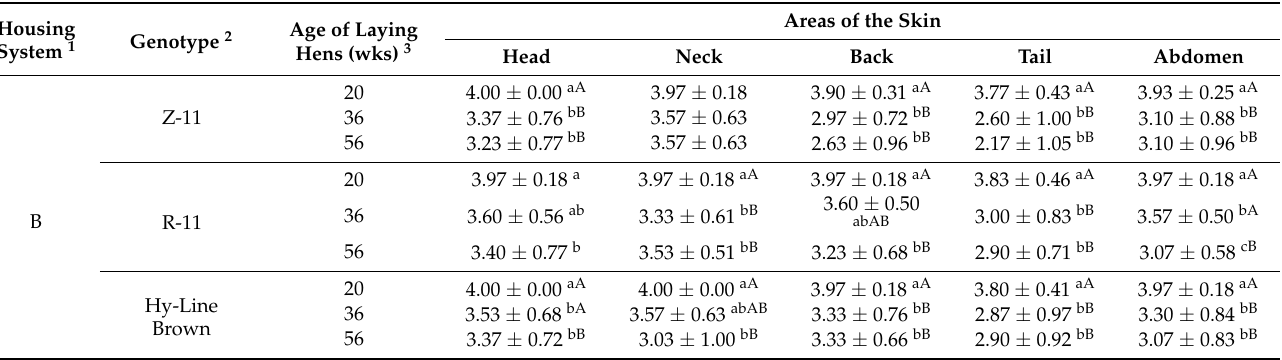
Table 1. The effect of the type of alternative housing system, genotype, and age of hens on the condition of plumage (on a scale of 0–4 points) of selected areas of the skin (0—very poor cover to 4—fully